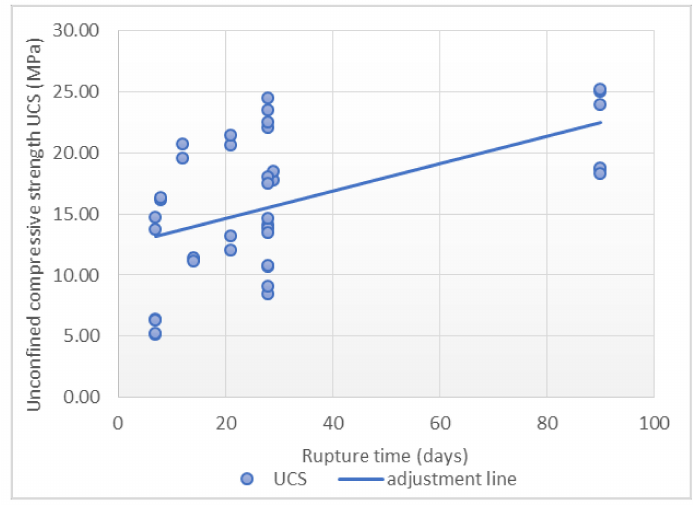
Figure 9. Relationship between rupture time and unconfined compressive strength.